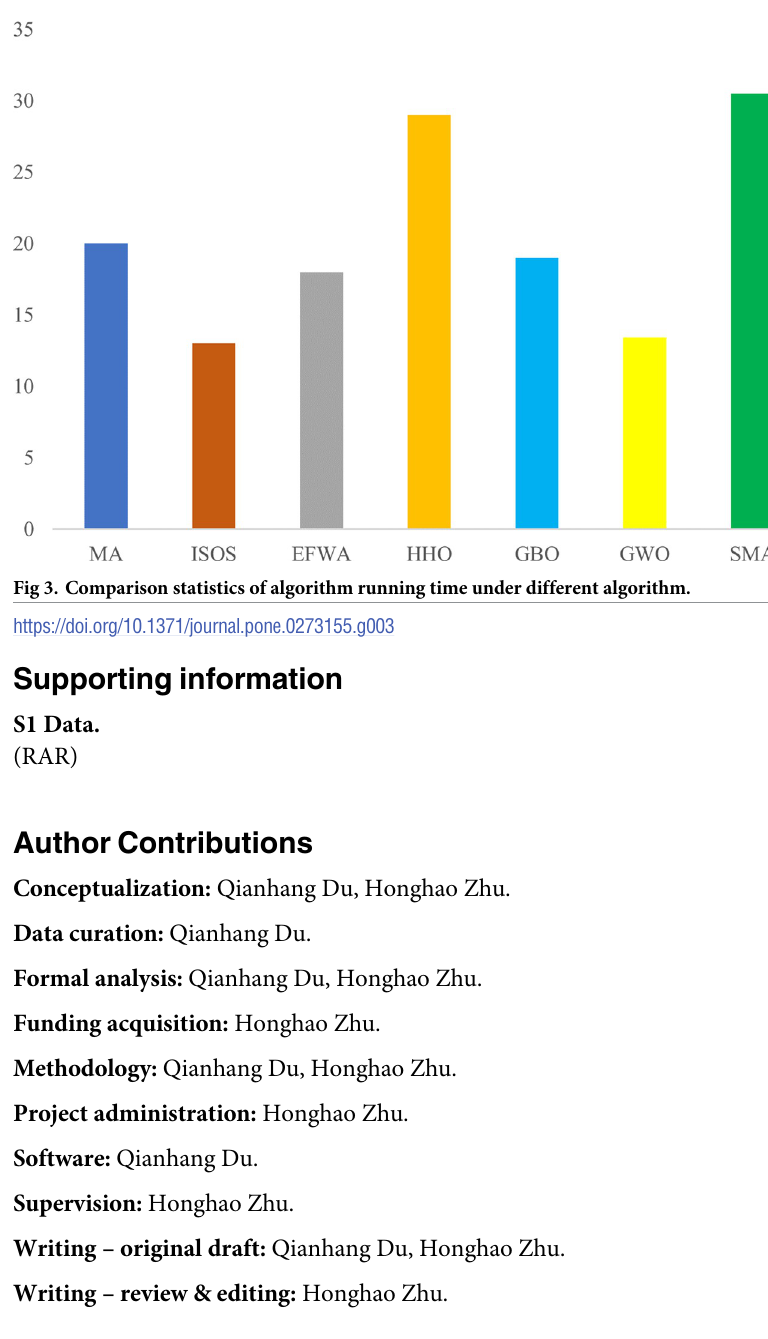
Fig 2. The average convergence curve of the algorithm under different calculation examples ((1)-(28) correspond to functions f1 - f28 respectively).